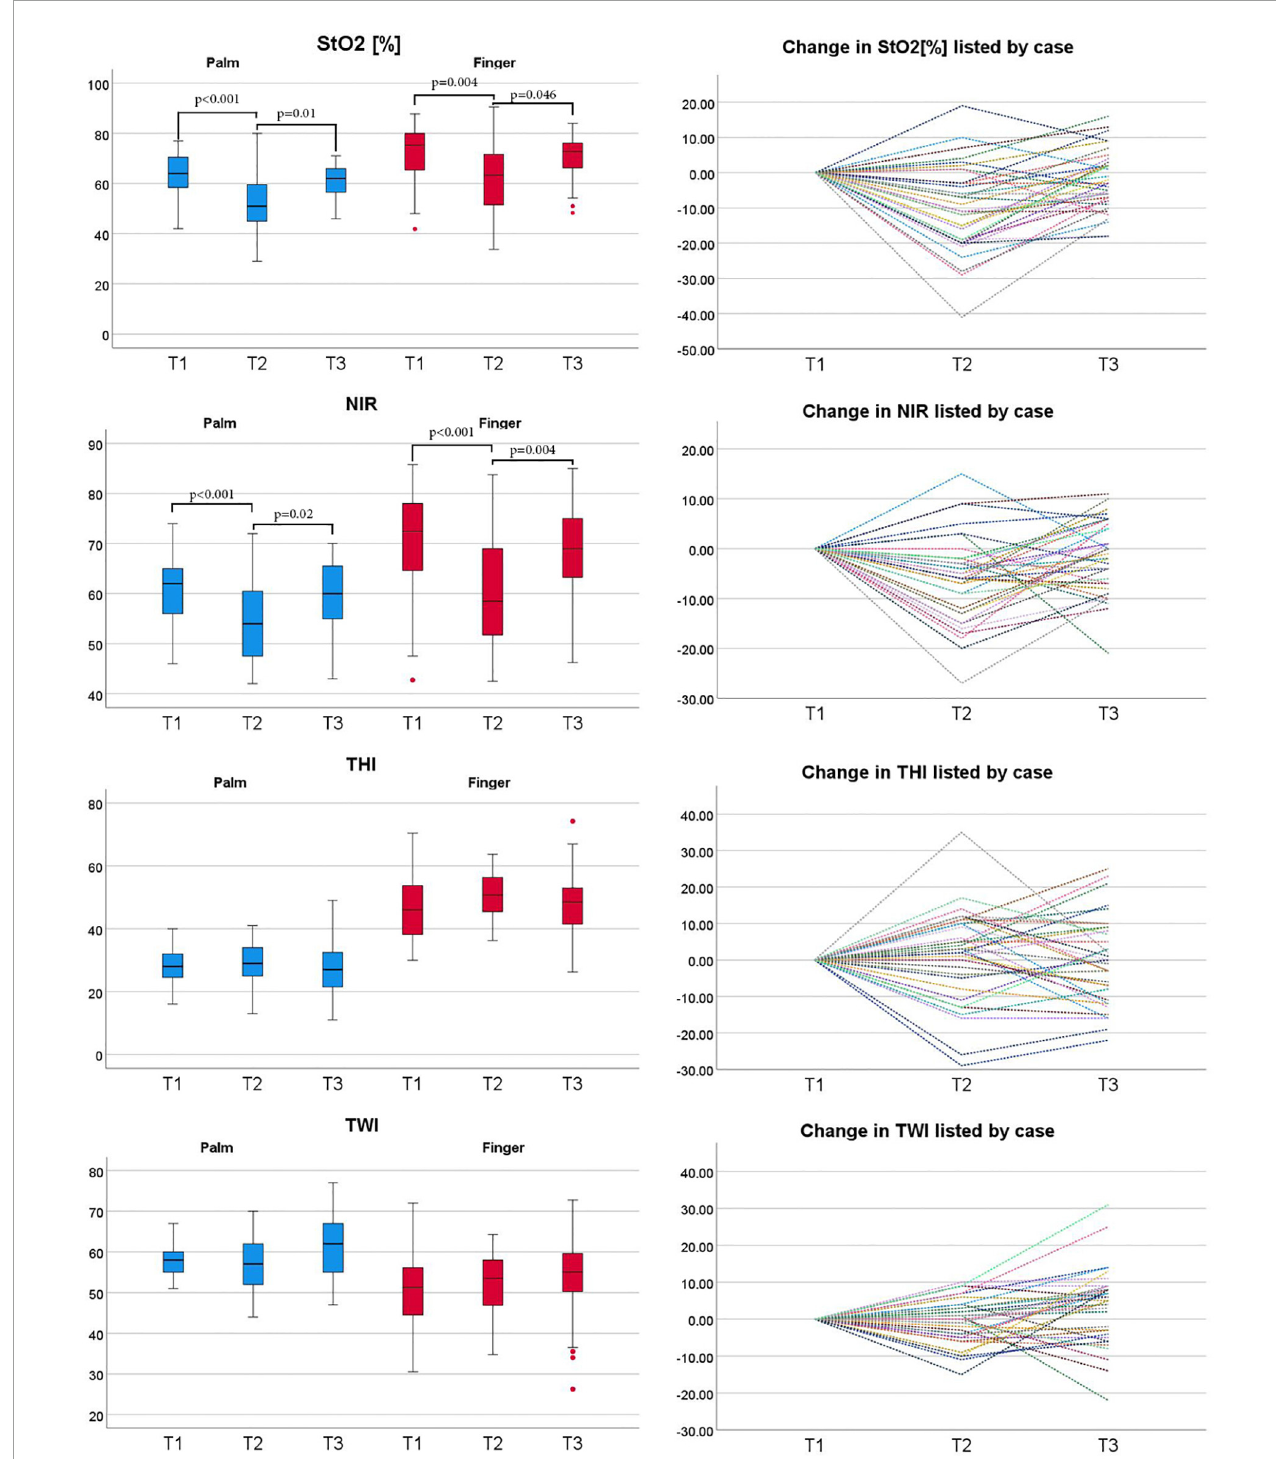
FIGURE2 The course of parameters derived from HSI in TAVI patients at the palm (blue) and fingertips (red). Line graphs show individual course of HSI measurements over time; HSI parameters were taken at three different timepoints: before valve replacement (T1), after valve replacement (T2) and 3 days after valve replacement (T3). Tissue oxygenation (StO2), tissue hemoglobin index (THI), near-infrared perfusion index (NPI), tissue water index (TWI) values range from 0 to 100. StO2 is given in% and THI, NPI, and TWI are index values in arbitrary units. Friedman-test was used for the statistical analysis. HSI, hyperspectral imaging; CABG, coronary artery bypass graft; TAVI, transcatheter aortic valve implantation.